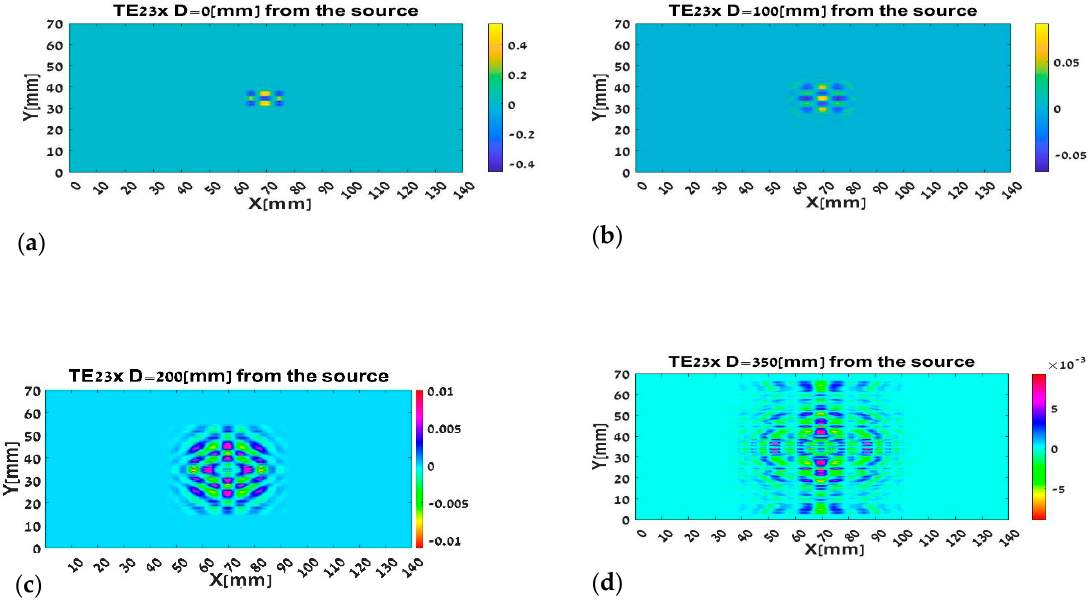
Figure 7. The TE 23 mode propagation in term of the rays: ( a ) at the out of the waveguide; ( b ) after passing 100 mm, and ( c ) after passing 200 mm, and ( d ) after passing 350 mm.